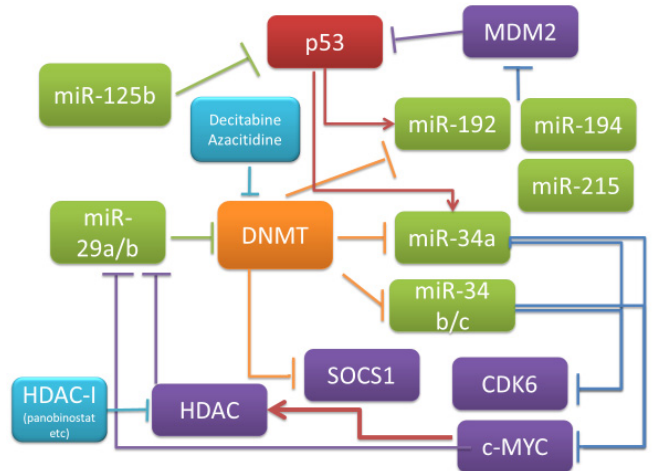
Figure 2. Feedback loop regulation network of microRNA and epigenetic modifier and potential drugs.